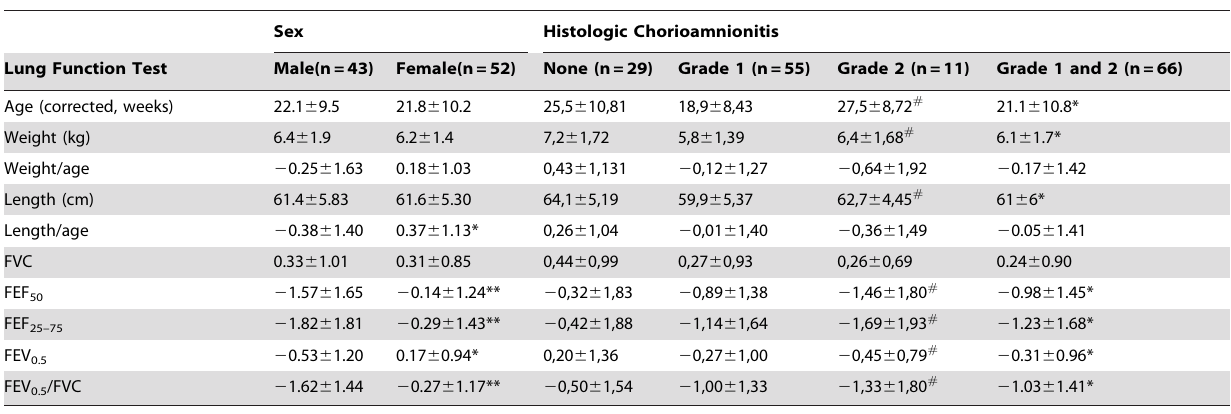
Table 2. Lung function values, stratified by sex and chorioamnionitis.